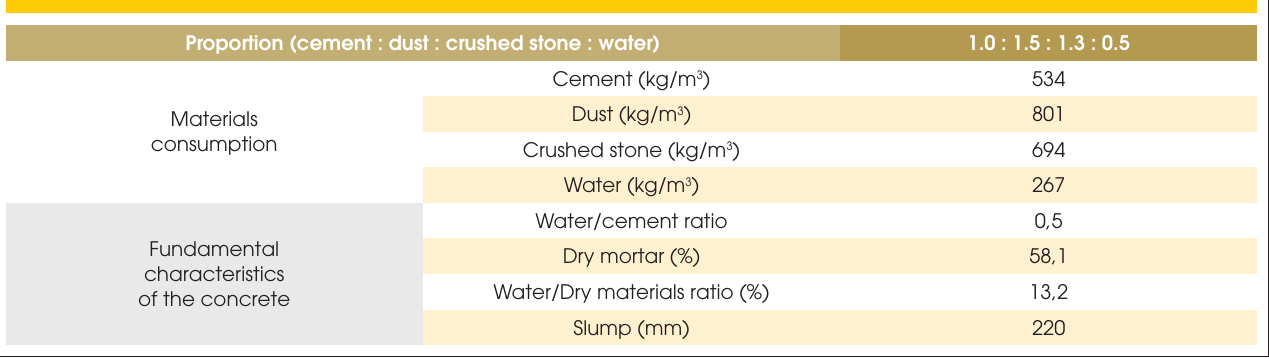
Table 3 – Materials consumption and fundamental characteristics of the concrete Proportion (cement : dust : crushed stone :